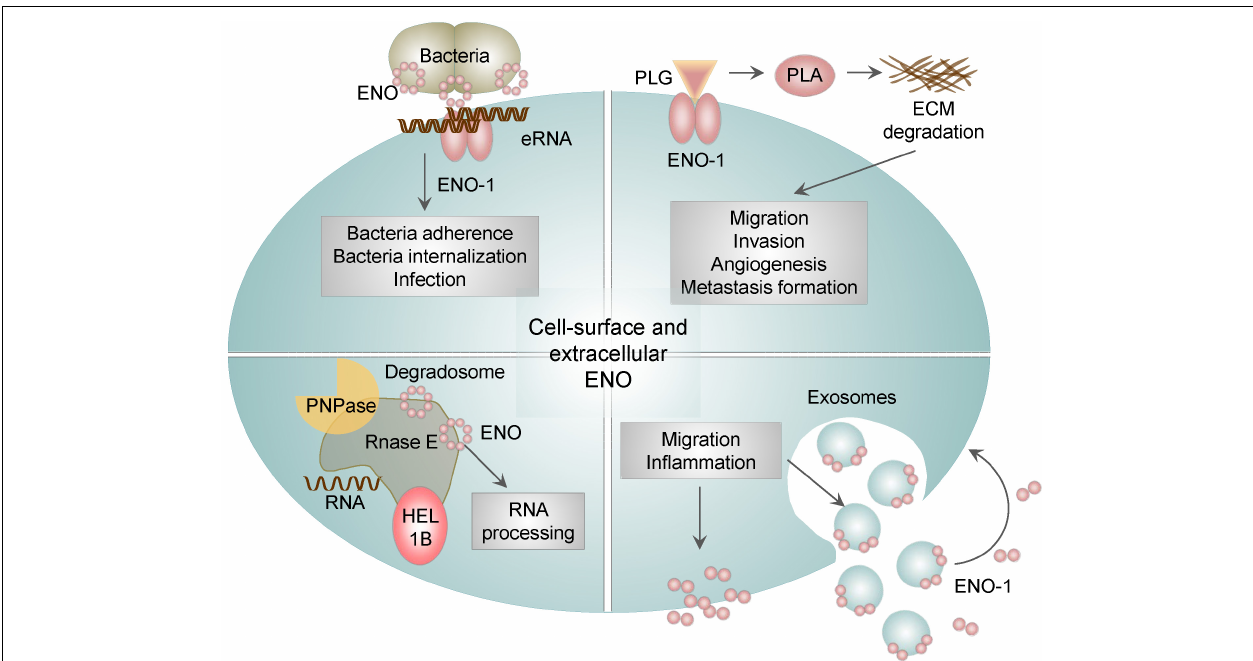
FIGURE 4 | The role of membrane bound and extracellular ENO. In addition to the intracellular activities, ENO-1 may be translocated to the cell surface or released into the extracellular environment as a free soluble protein or bound to exosomes. Surface bound ENO-1 acts as a plasminogen (PLG) binding receptor and participates in plasmin (PLA) formation, which degrades extracellular matrix proteins (ECM). Furthermore, cell surface ENO-1 can bind extracellular RNA (eRNA), which may act as a bridging molecule between bacterial ENO and eukaryotic ENO-1 and thus facilitate bacterial dissemination. In addition, ENO is a part of the bacterial degradosome, which consists of RNase E, RNA helicase 1B (HEL1B) and polynucleotide phosphorylase (PNPase). ENO binding to the degradosome affects the activity of the complex and consequently cellular RNA processing. Lastly, ENO-1 secreted outside of the cell either in the form of exosomes or as a free floating protein may induce migration and a pro-inflammatory phenotype of immune